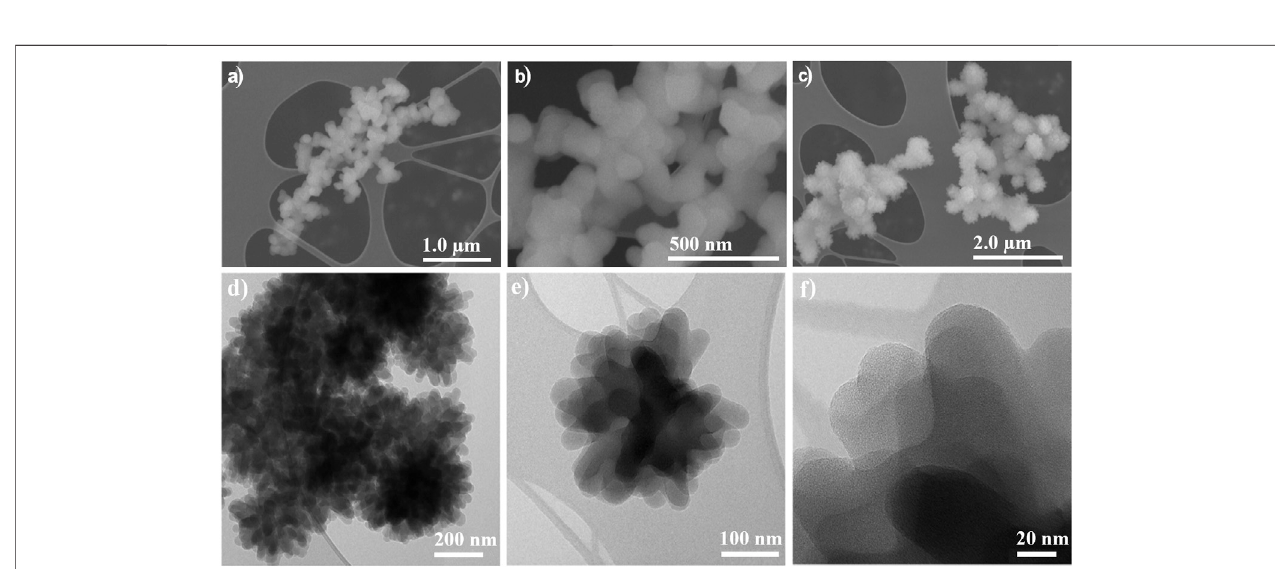
FIGURE 2 | (A,B) SEM images of C-COP DMSO ; (C) SEM image; and (D – F) TEM images of the F-COP DMF with different size